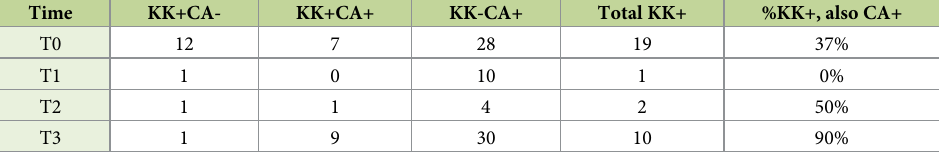
Table 6. Results of all faecal samples which tested positive during the MDA pilot control program for T . solium in Madagascar. Results shown for the 20 villages tested at each time-point. Different batches of reagents were used for the copro-antigen tests undertaken at each time